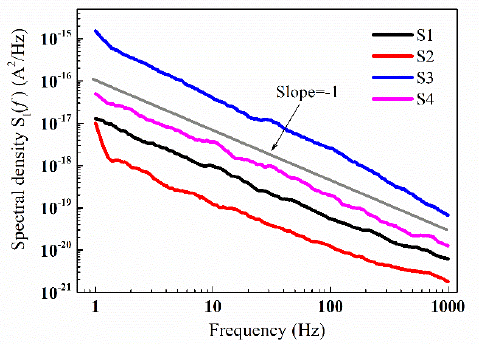
Figure 6. The current noise power spectral density of the typical samples under 0.1